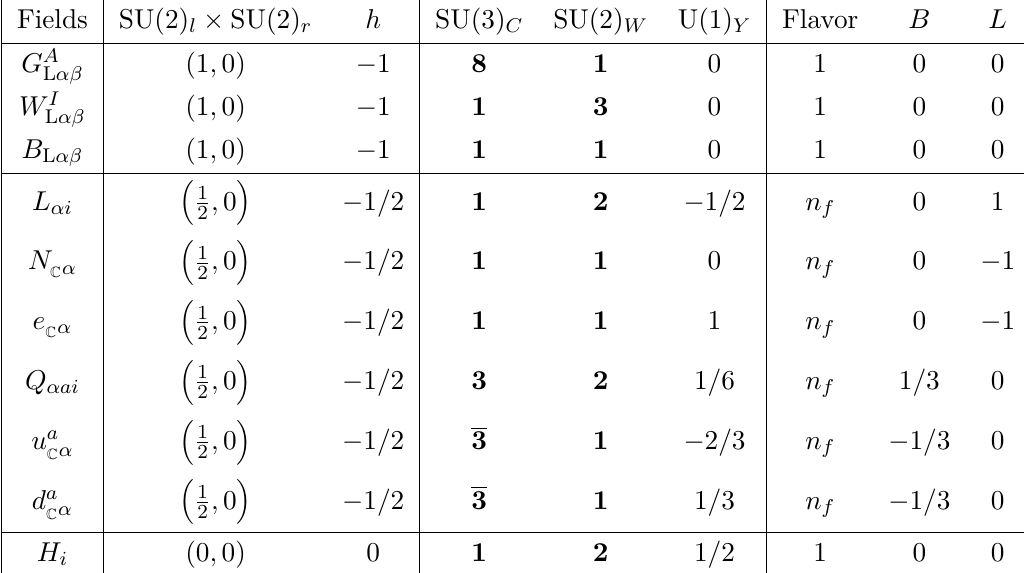
denote the right-handed neutrinos. The representation under C ) , while the helicity of the field is given by h = j . The l , j r r − j l , which is 3 in the standard model. Their global charges, f ) † = F for gauge bosons, ( ψ ) † = ( ψ † ) for L αβ α ˙ α R ˙ α ˙ β